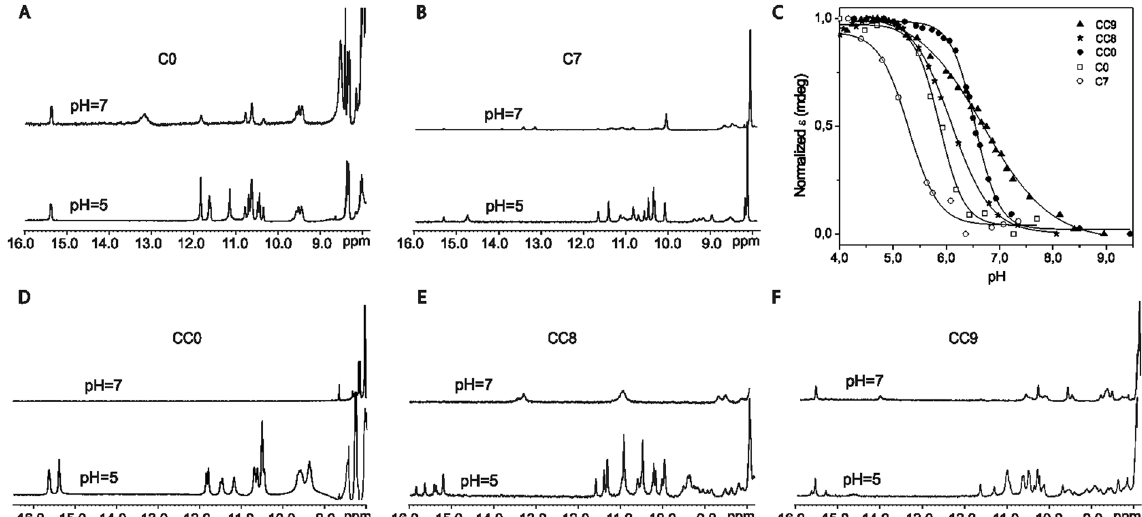
Figure 2. CC9 forms i-motif structure at neutral pH. 1D 1 H-NMR spectra at different pH. H 2 O/D 2 O 90:10, 25 mM phosphate buffer, 100 mM NaCl, T = 5 °C, [oligonucleotide] = 0.7–1 mM ( A , B , D – F ). CD pH titration of the 11-mer sequences were followed at the ellipticity maximum at pH 4: λ = 265 nm ( C0 , CC8 and CC9 ) and λ = 265 nm ( C7 and CC0 ), 25 mM AcONa buffer, 100 mM NaCl, T = 5 °C, [oligonucleotide] = 20 μ M ( C